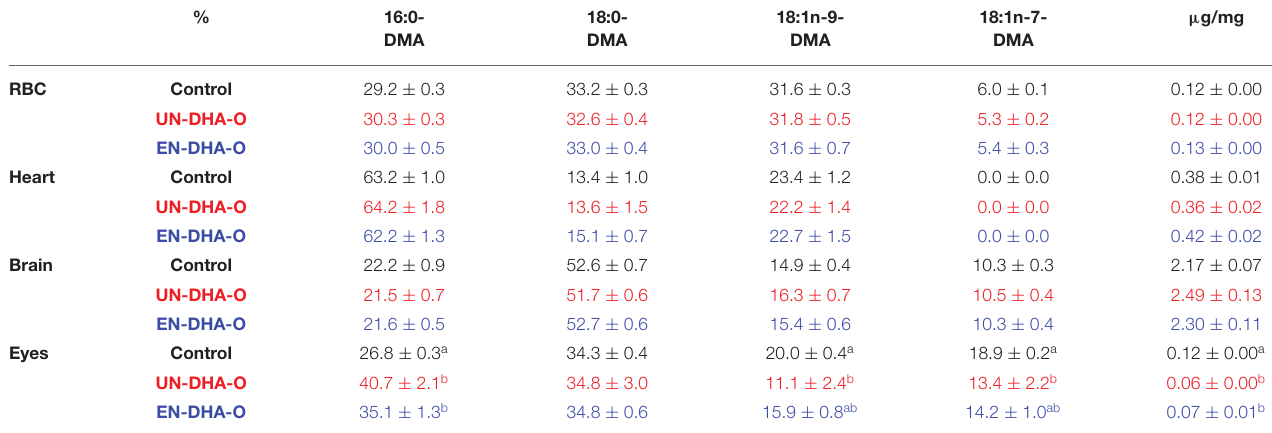
TABLE 4 | The dimethylacetal profile of RBC, heart, brain, and eyes.